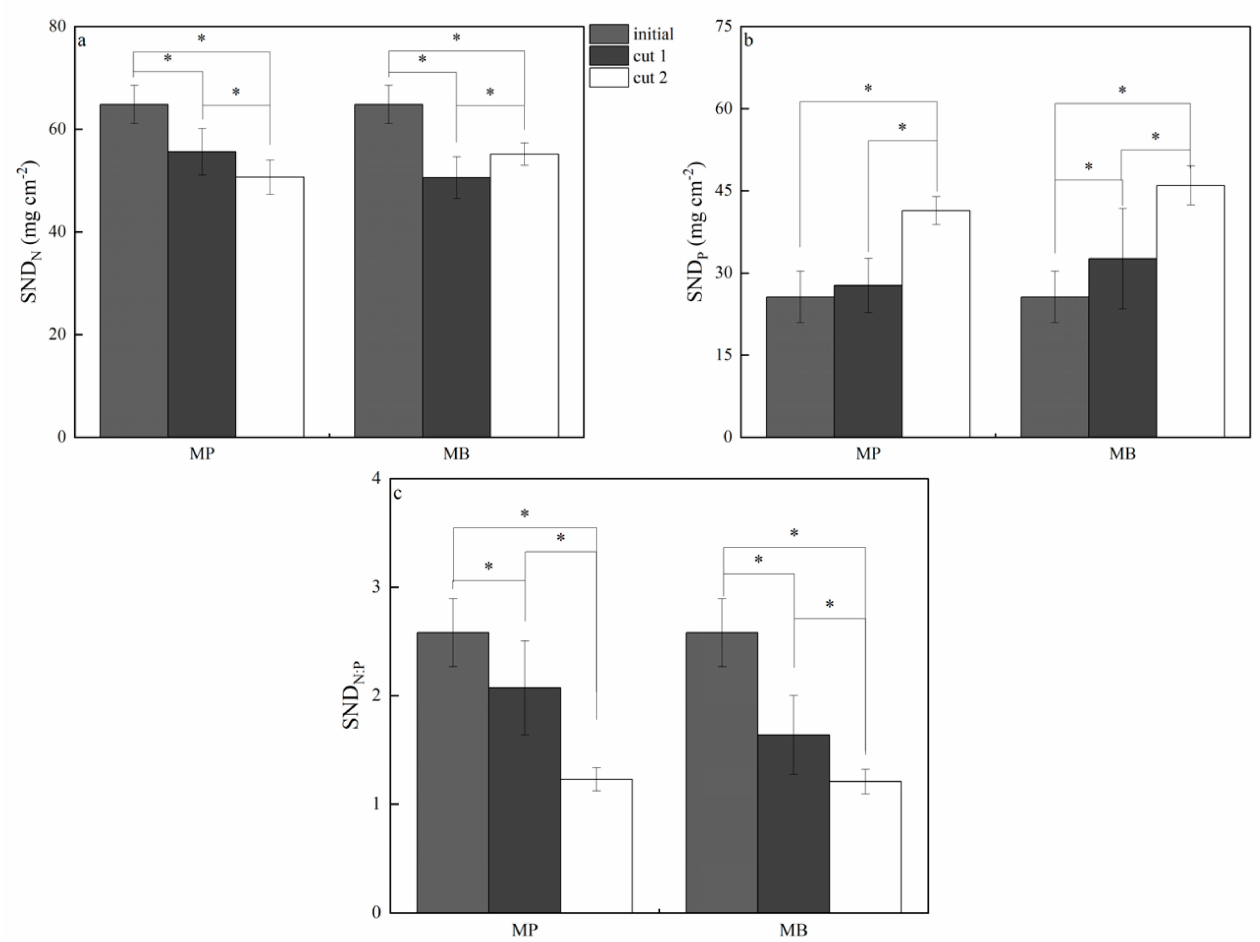
Figure 5. Cut-level soil ( a ) N density (SND N ), ( b ) P density (SND P ), and ( c ) N:P density ratio (SND N:P ) under different species combinations. Values are the means ± SD (n = 9). Soil nutrition status was measured at the initial stage and the flowering stage of cuts 1 and 2. Asterisks (*) show significant differences between the initial, cut 1, and cut 2 values of the same grassland at p <